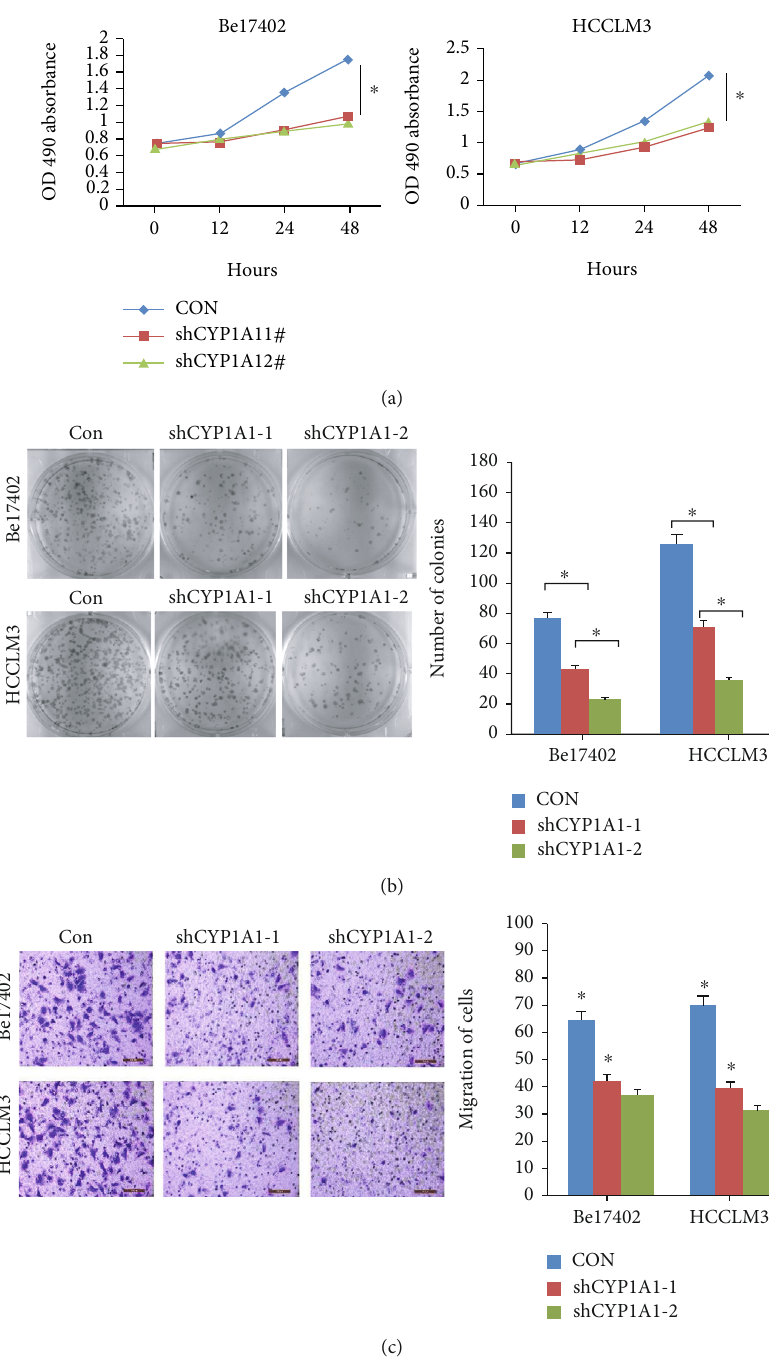
Figure 1: Speci fi c e ff ects of CYP1A1 knockdown and overexpression on liver cancer cell aggressiveness. (a) CYP1A1 knockdown signi fi cantly inhibited liver cancer cell viability. (b) CYP1A1 knockdown signi fi cantly inhibited liver cancer cell colony formation. (c) CYP1A1 knockdown remarkably suppressed liver cancer cell